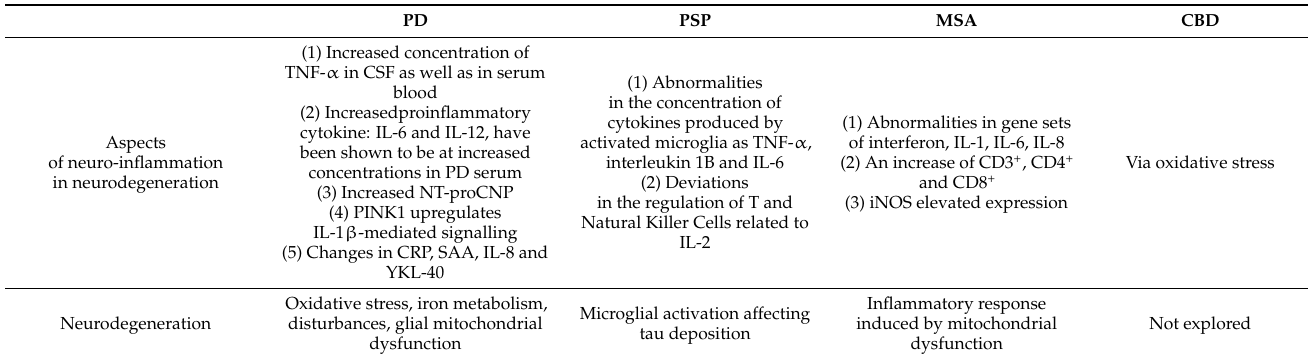
Table 3. Immunological abnormalities in